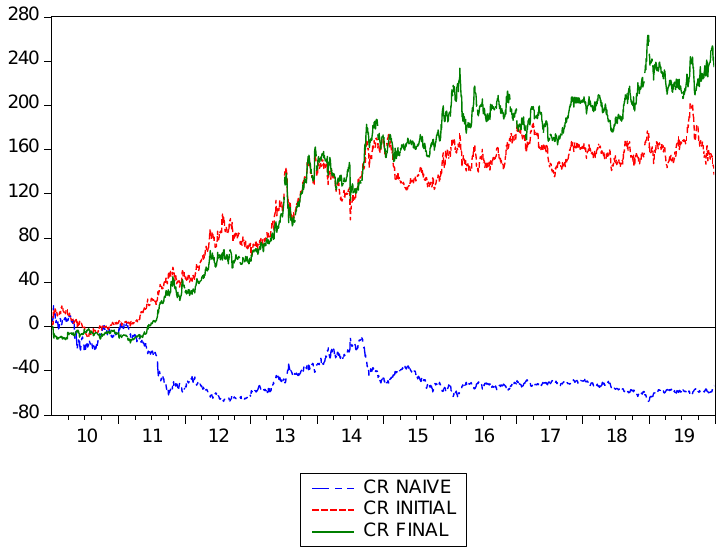
Figure 2. Cumulative returns of strategies. This figure displays the cumulative returns over the out-of-sample period for the naïve strategy, the best strategy using logarithm returns, labeled as initial, and the best one using standardized returns, labeled as final.